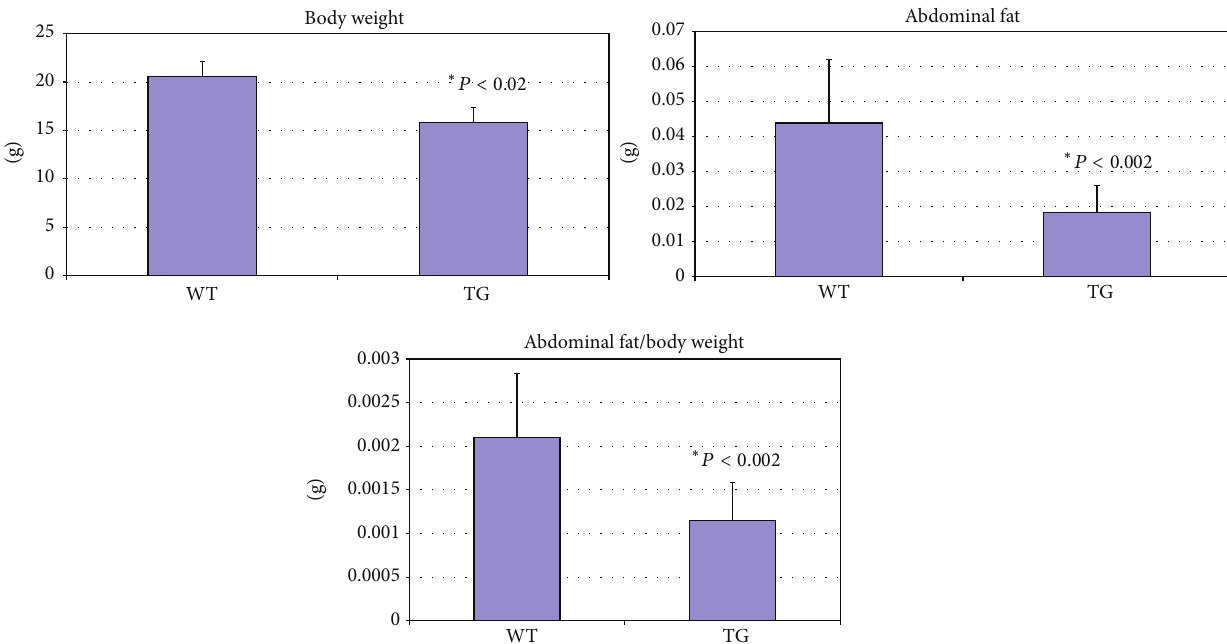
Figure 5: 𝑁𝐴𝐺 - 1 𝑇𝑔/𝐿𝑜𝑥 mice show lower body weight and less abdominal fat tissue than wild-type mice. 10 female WT and 10 female 𝑁𝐴𝐺 - 1 𝑇𝑔/𝐿𝑜𝑥 mice were injected with LPS intraperitoneally. After 4 hrs of LPS treatment, mice were sacrificed and weighed. Blood was collected for serum isolation and abdominal fat tissue was collected, weighed, and snap